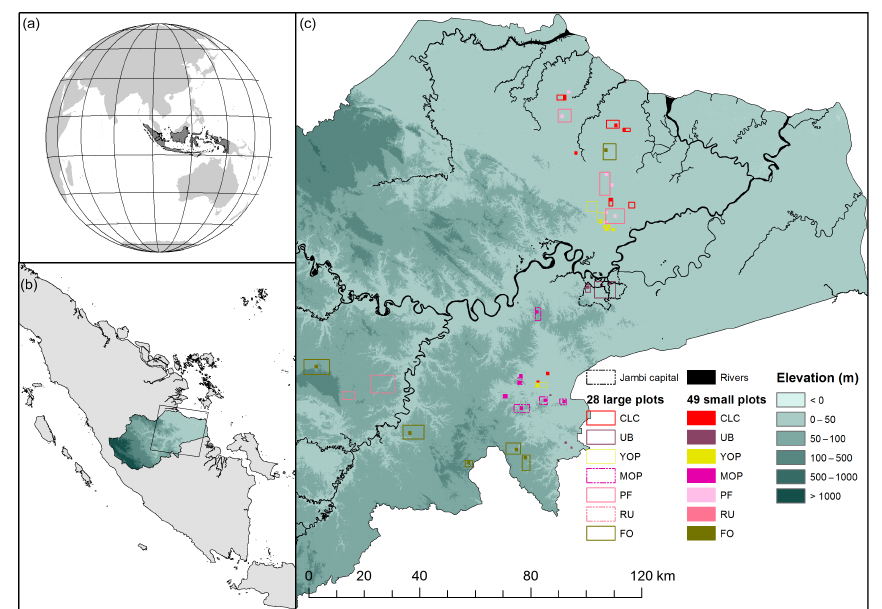
Figure 1. Geographic location of the study area. Jambi province on the Sumatran Island of Indonesia (a, b) . The background of the map (c) is a digital elevation model, showing that the plots are located in the lowlands of the Jambi province. The large rectangles are the 28 different land cover types; the small squares are the locations of the 49 small plots of the 7 different land cover types. The land cover types are abbreviated as CLC (clear-cut land), UB (urban area), YOP (young oil palm plantation), MOP (mature oil palm plantation), PF (acacia plantation forest), RU (rubber plantation) and FO